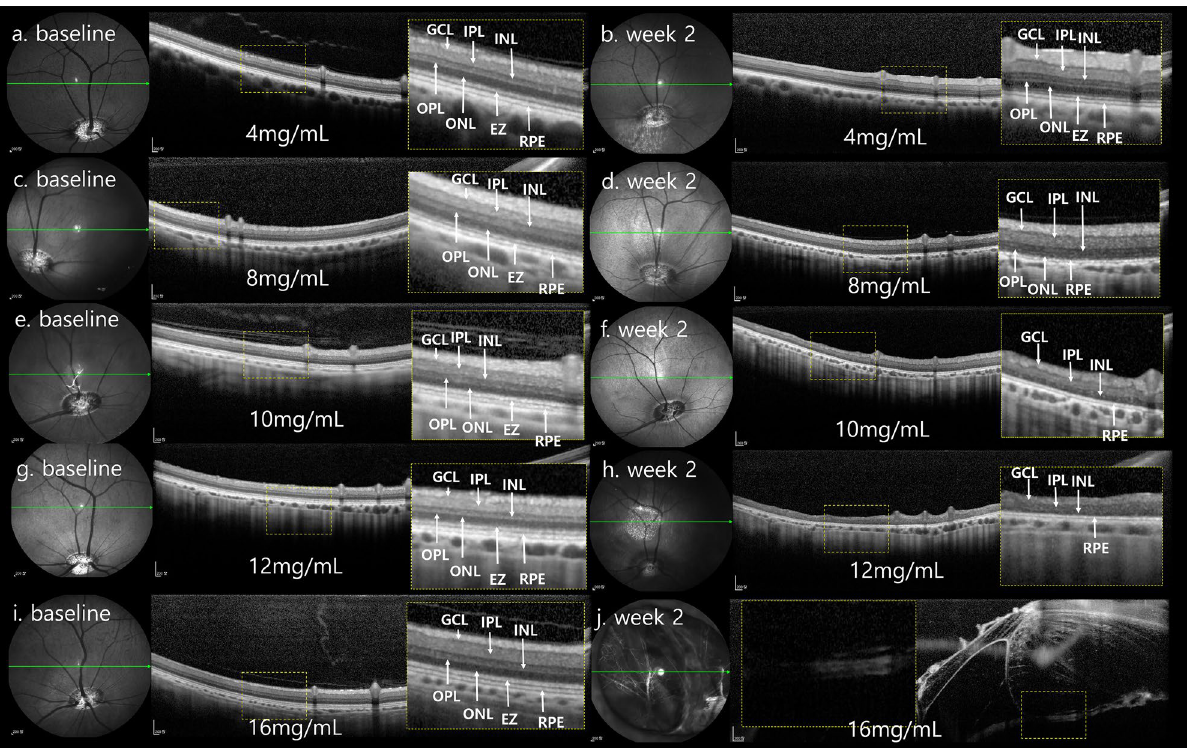
Figure 2. SD-OCT findings of the retina in one case of each 4 mg/mL, 8 mg/mL, 10 mg/mL, 12 mg/mL, and 16 mg/mL MNU at baseline and week 2. ( a – j ) Each magnified SD-OCT image of the case is on the right sided and shown with a dashed-line box. ( a , b ) OCT image of the 4 mg/mL MNU case showed intact GCL, INL, ONL, photoreceptor layer, and RPE at baseline and week 2. ( c , d ) OCT image of the 8 mg/mL MNU case at week 2 showed an intact ganglion cell layer and retinal pigment epithelium. The boundary of the INL and ONL became indistinct compared with the SD-OCT image at baseline ( c ). The EZ representing the photoreceptor layer became obscure. OCT images of the 8 mg/mL MNU case at weeks 6 and 12 weeks showed no change compared with that at week 2 (Supplementary Fig. 2). ( e , f ) On the OCT, unlike baseline, the EZ and ONL were indistinguishable at week 2 in the 10 mg/mL MNU case. However, there was no significant decrease in INL thickness. ( g , h ) On the OCT, unlike baseline, the EZ and ONL were indistinguishable at week 2 in the 12 mg/ mL MNU case. In addition, there was a decrease in INL thickness. The total retinal thickness of the 12 mg/mL MNU case at week 6 was thinner than at week 2 (Supplementary Fig. 2). ( i , j ) After week 2, the retina melted and induced retinal detachment in SD-OCT images of the 16 mg/mL MNU case. SD‑OCT spectral domain optical coherence tomography, MNU N -methyl- N -nitrosourea, GCL ganglion cell layer, IPL inner plexiform layer, INL inner nuclear layer, OPL outer plexiform layer, ONL outer nuclear layer, EZ ellipsoid zone, RPE retinal pigment at week 2 and at week 6. The mean amplitude of b-waves in the DA 0.01 ffERG showed a significant decrease at week 2, but no difference was evident between weeks 2 and 6. The mean implicit time in DA 10.0 ffERG showed a temporal delay at week 2. The mean amplitude in the DA 10.0 ffERG decreased at week 2 and then remained low from week 2 to week 6. The mean implicit time in LA 3.0 ffERG was not changed at weeks 2 and 6. The mean amplitude in LA 3.0 ffERG showed a decrease at week 2 and remained low at week 6. The mean amplitude of LA 3.0 flicker showed a decrease at week 2 and remained low at week 6 (Fig. 5, Table 1). Fundus infrared reflectance and spectral‑domain optical coherence tomography. SD-OCT images at week 2 showed intact GCL and RPE. The ellipsoid zone on 55-degree SD-OCT fields was barely distinguishable at week 2 (Fig. 6), and outer plexiform layer thickness decreased. From week 2 to week 6, subsequent changes were mini- mal and similar among layers. Mean thicknesses of INL, ONL, and TRL showed significant decrease at week 2. From week 2 to week 6, changes were minimal (Fig. 7, Table 2). Hematoxylin and eosin and immunohistochemistry. In H&E staining of moderate degeneration cases (n = 9), the INL, GCL, and NFL were nearly intact (Fig. 8). Rhodopsin staining showed severely decreased rod cells, and PNA staining showed focal intact cone cells. RPE65 staining showed intact RPE and rare co-staining of photoreceptors. NeuN staining showed intact ganglion cells and co-staining of few photoreceptors. PKC-α stain- ing showed intact bipolar cells, and GFAP staining showed nearly normal Müller cells. No apoptotic cells were evident in Tunel staining (Fig. 9).